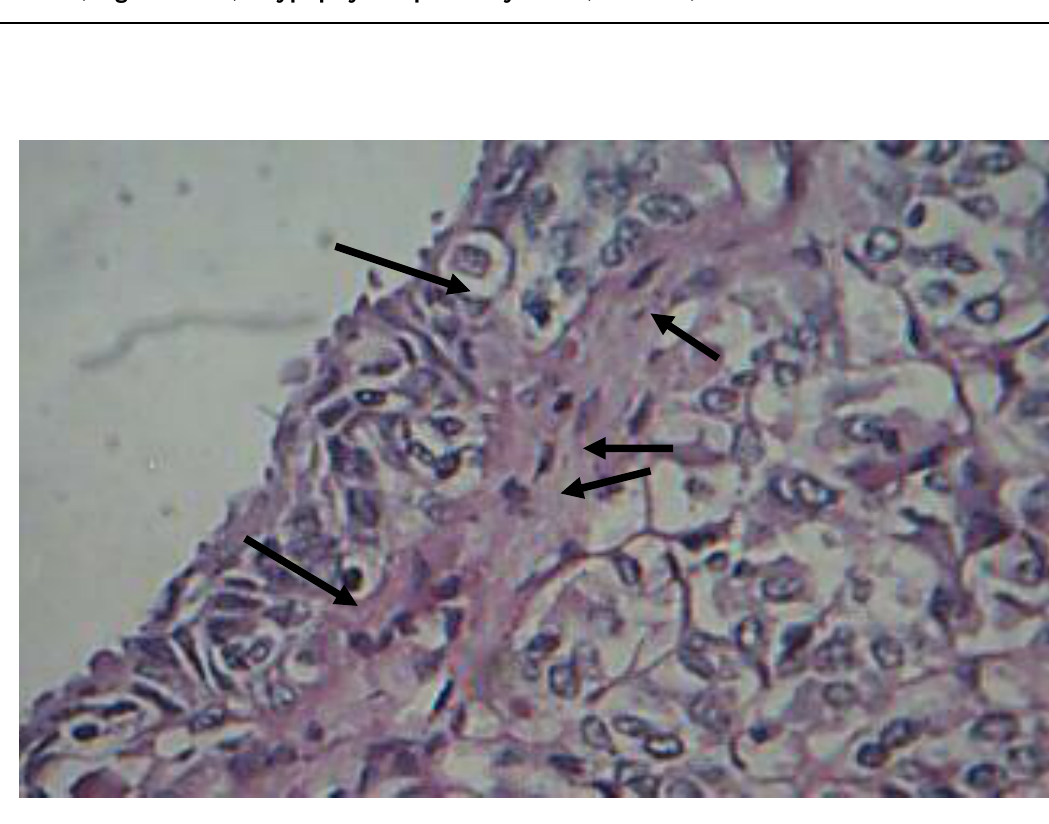
Fig. ( 2 ). Pars tuberalis in buffalo showing water-clear cell (large arrows) and magenta syncytial cell (small arows). PAS stain.